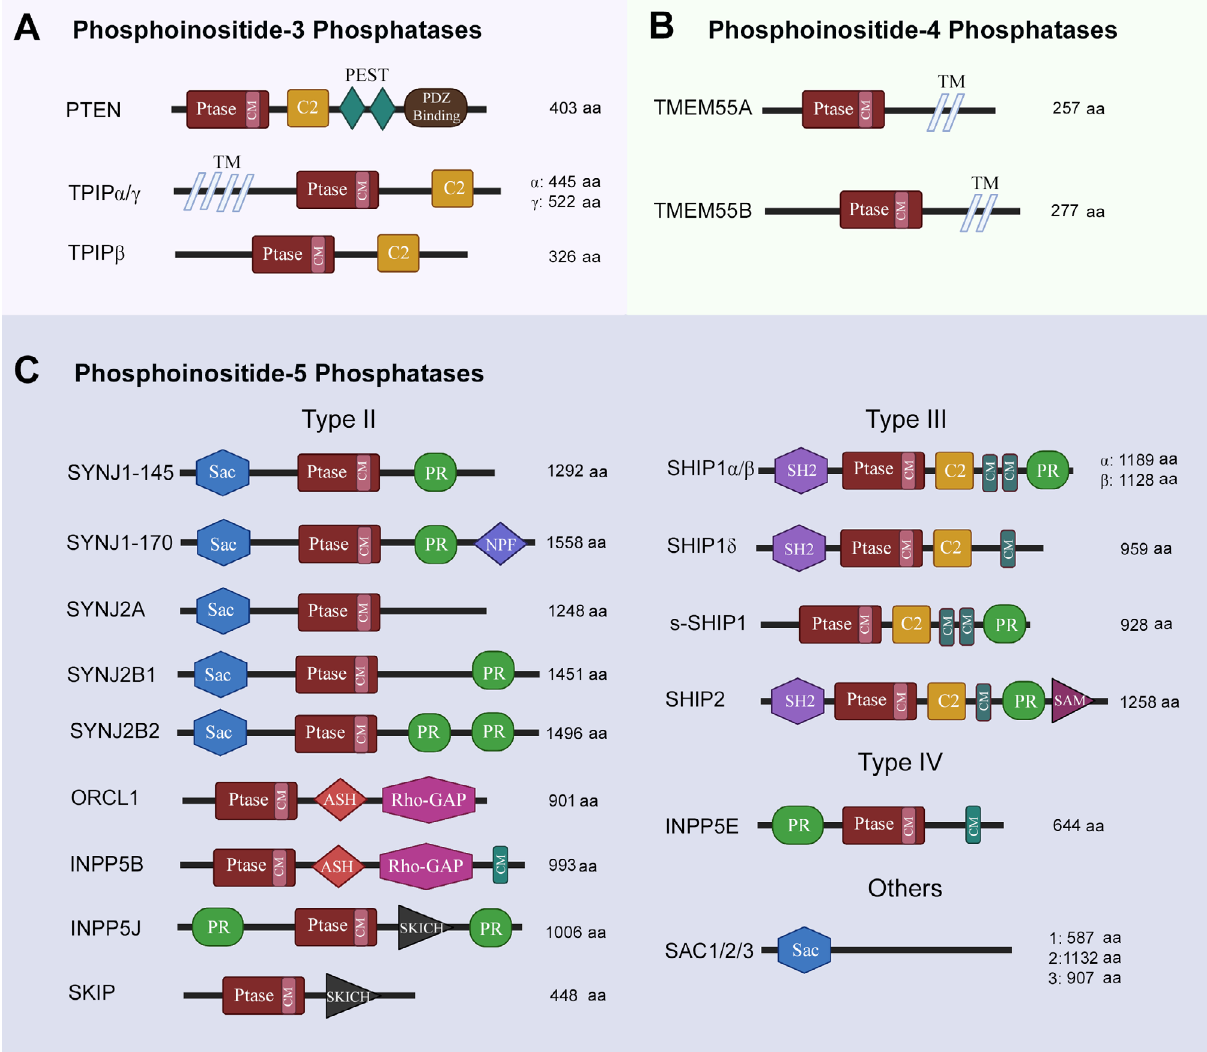
Figure 3. Structural features of phosphoinositide phosphatases. Ptase: phosphatase domain; CM: consensus motif; PEST: proline, glutamine, serine, threonine-rich sequence; TM: transmembrane spanning region; NPF: asparagine, proline, phenylalanine repeats; SKICH: skeletal muscle- and kidney-enriched inositol polyphosphate phosphatase (SKIP) carboxyl hydroxy